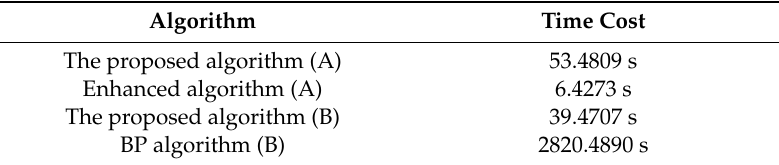
Table 4. C omparison on time cost of different algorithms for numerical simulation.